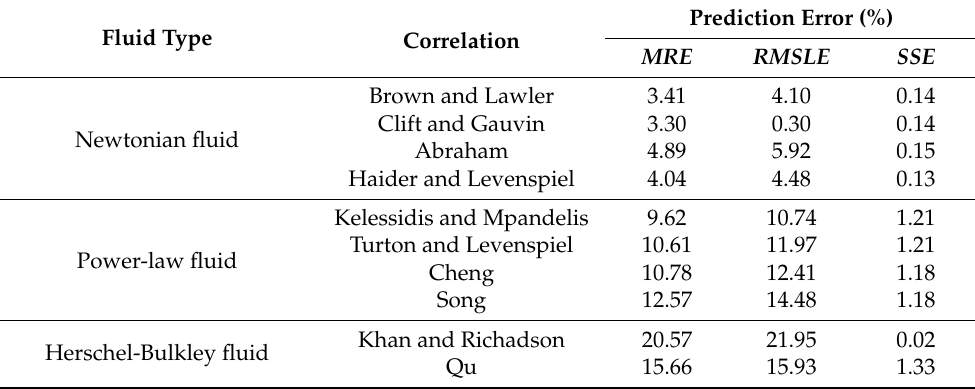
Table 4. Error statistics of SDCSPs in Newtonian fluid (NF) and non-Newtonian fluid (NNF). Fluid Type